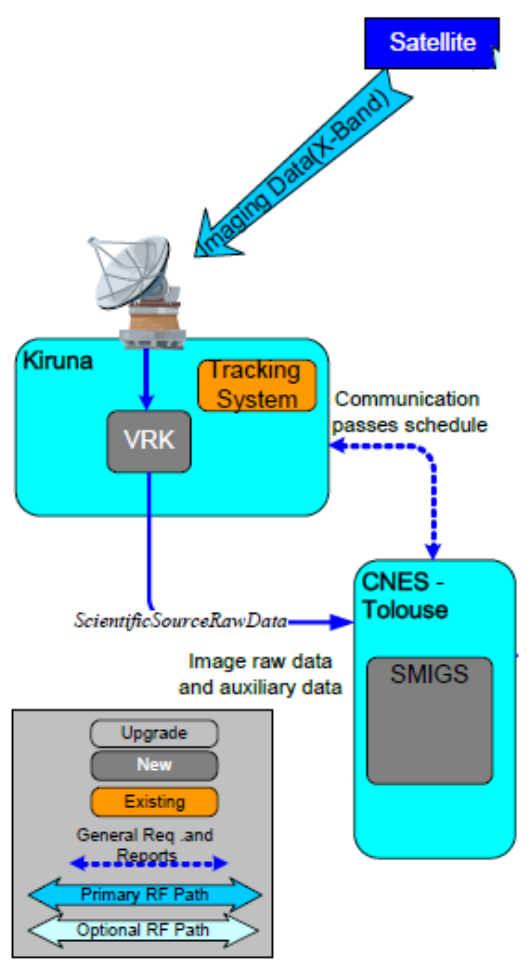
Figure 38. Data reception chain overview. Figure 39. Data reception chain